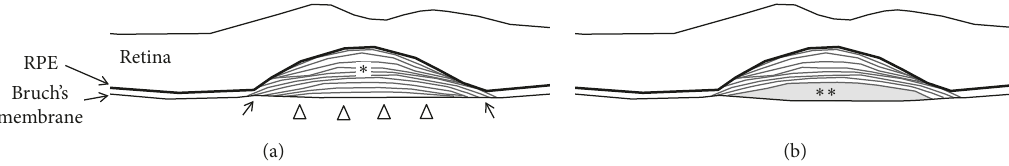
Figure 5: A schematic drawing showing the postulated developmental mechanism of prechoroidal cleft. (a) The subretinal pigment epithelial (RPE) fibrovascular tissue (asterisk) and Bruch’s membrane may not attach or may be only weakly attached in some regions (arrowheads). However, around these regions, the two tissues attach firmly (arrows). (b) When sub-RPE tissue becomes contracted or leaks, prechoroidal cleft develops in the area of weak adhesion between tissues. The firmly attached area impedes further extension of the